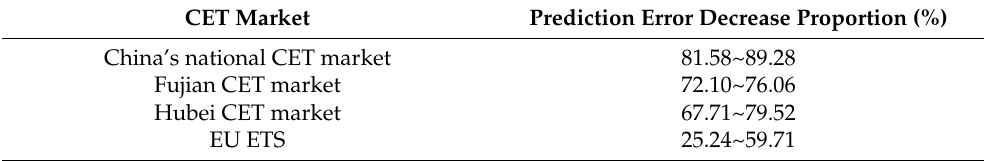
Table 7. The decrease in prediction error of CEEMDAN-XGBoost(W-b) compared to other